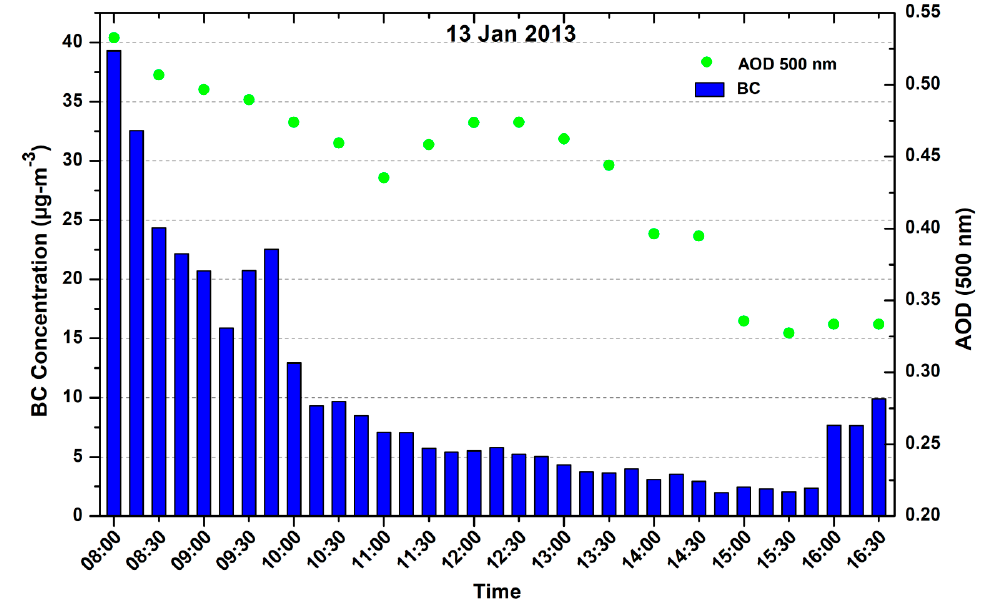
Figure 6. Day time (h) aerosol optical depth (AOD) (500 nm) and BC variation over the fixed measurement site in Singrauli.